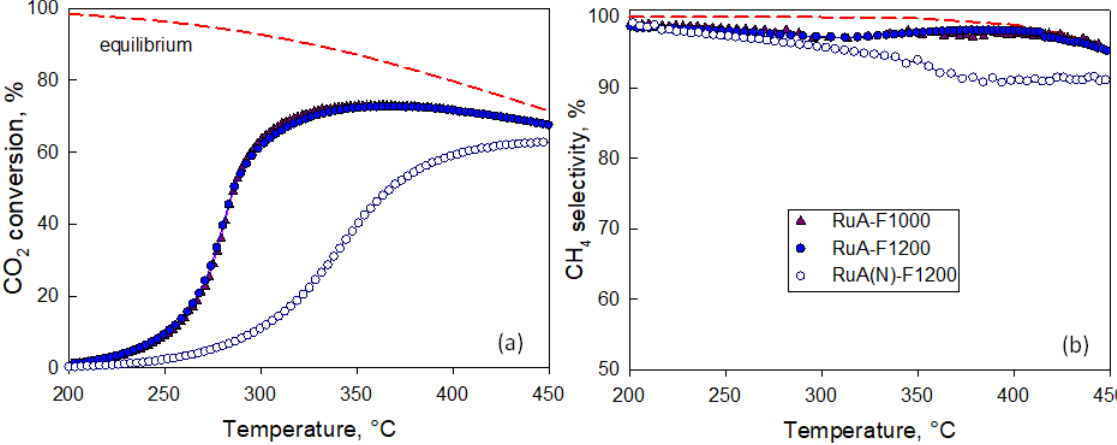
Figure 6. CO 2 conversion ( a ) and corresponding selectivity to CH 4 ( b ) as a function of the preheating temperature. The only other detected product of reaction was CO. Feed: CO 2 /H 2 /N 2 = 1/4/5. Red dashed lines represent thermodynamic equilibrium values (at constant T and P).